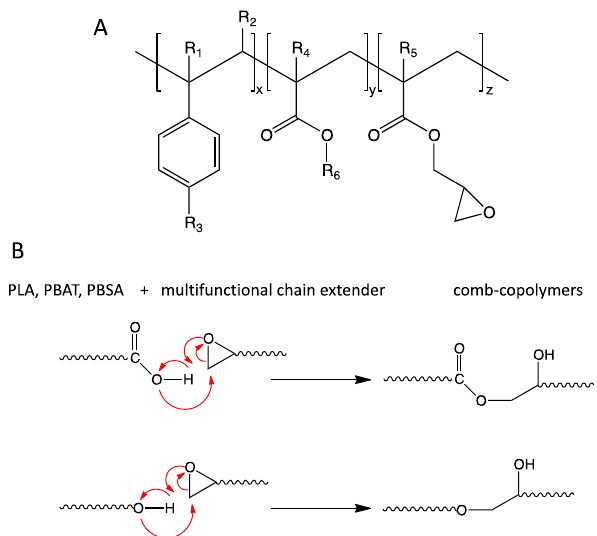
Figure 7. ( A ): Chemical structure of Joncryl where x, y, z range between 1 and 20; R 1 , R 2 , R 3 and R 4 are H, -CH 3 or higher alkyl group; R 6 is an alkyl group; ( B ): schematic representation of reactions between the end groups of polyesters and the epoxy ring of chain extenders.